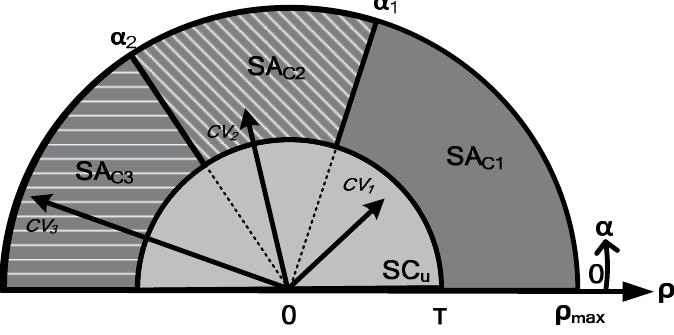
Figure 2. Polar representation of proposed SAW-CVA approach [11].